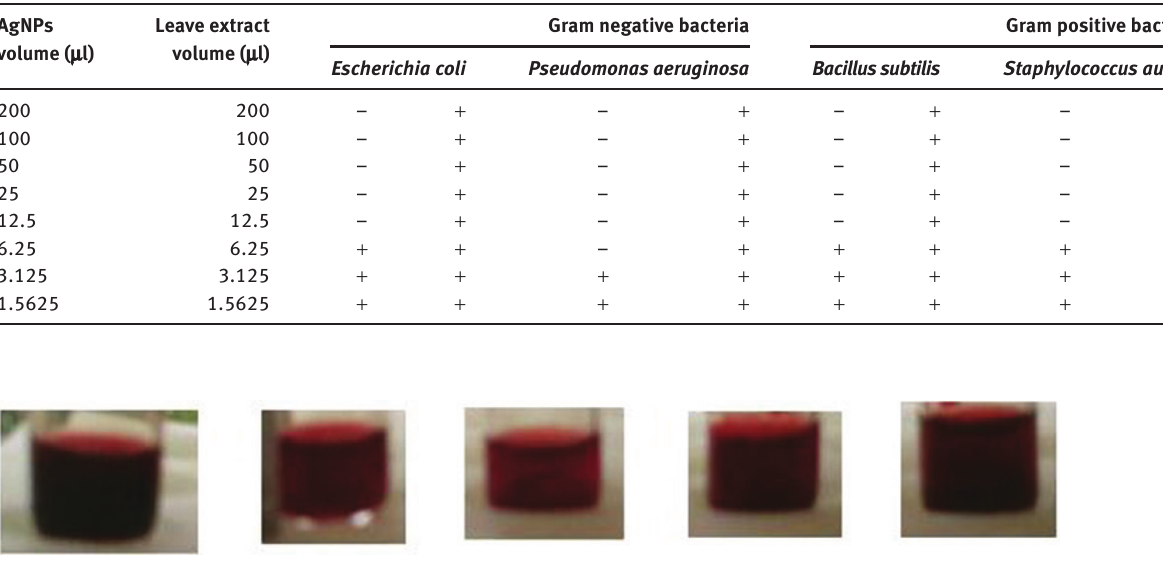
Figure 8: Anticoagulation effect of silver nanoparticles (AgNPs). Left tube: blood + extract; right tubes: blood + AgNP (with increasing of AgNP dilution).